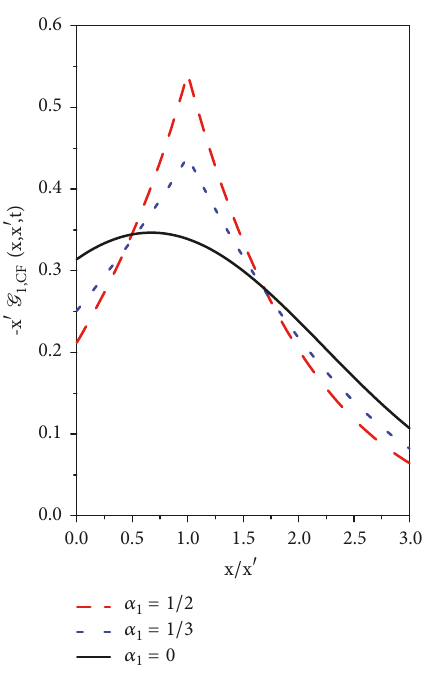
Figure 3: This figure illustrates the behavior of (29) by considering different values of 𝛼 1 . We consider, for simplicity, 𝜏 1,𝐶𝐹 = √𝑥 󸀠2 /𝐷 1 , /𝑥 󸀠 = 1 , 𝜏 = 1 , and 𝛼 = 1/2 , in arbitrary 𝑘𝜏 1,𝐶𝐹 1,𝐶𝐹 1